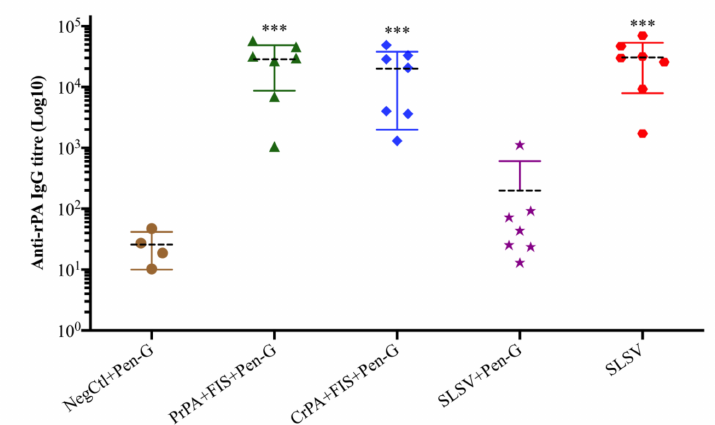
Figure 2. Anti-recombinant protective antigen (rPA) IgG-titres at week 5 in cattle. The cattle were vaccinated twice at weeks 0 and 3 with PrPA + FIS + Emulsigen-D ® / Alhydrogel ® plus Pen G ( n = 7), CrPA + FIS + Emulsigen-D ® / Alhydrogel ® plus Pen G ( n = 7), Sterne live spore vaccine (SLSV) plus Pen-G ( n = 7), SLSV ( n = 7) and NegCtl (Emulsigen-D ® / Alhydrogel ® plus Pen-G) ( n = 4). The IgG titres of each group were compared to the respective titres at week 0 before vaccination (*** p < 0.001, ** p < 0.01, * p ≤ 0.05). Purified recombinant protective antigen: PrPA; Crude recombinant protective antigen: CrPA; Formalin inactivated Bacillus anthracis spores: FIS; Penicillin-G: Pen-G; Sterne live spore vaccine: SLSV; Negative control: NegCtl.